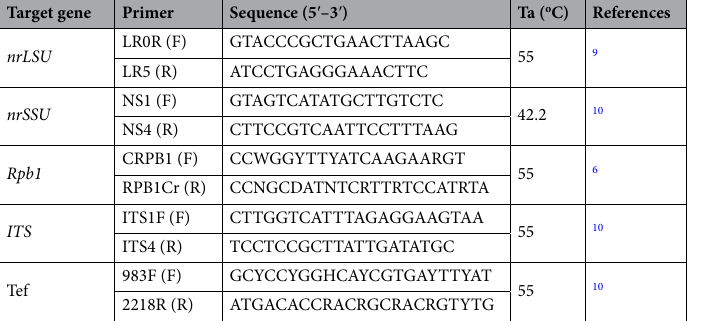
Table 1. The primers’ sequence used in this study. F: Forward primer; R: Reverse primer; T a : Annealing